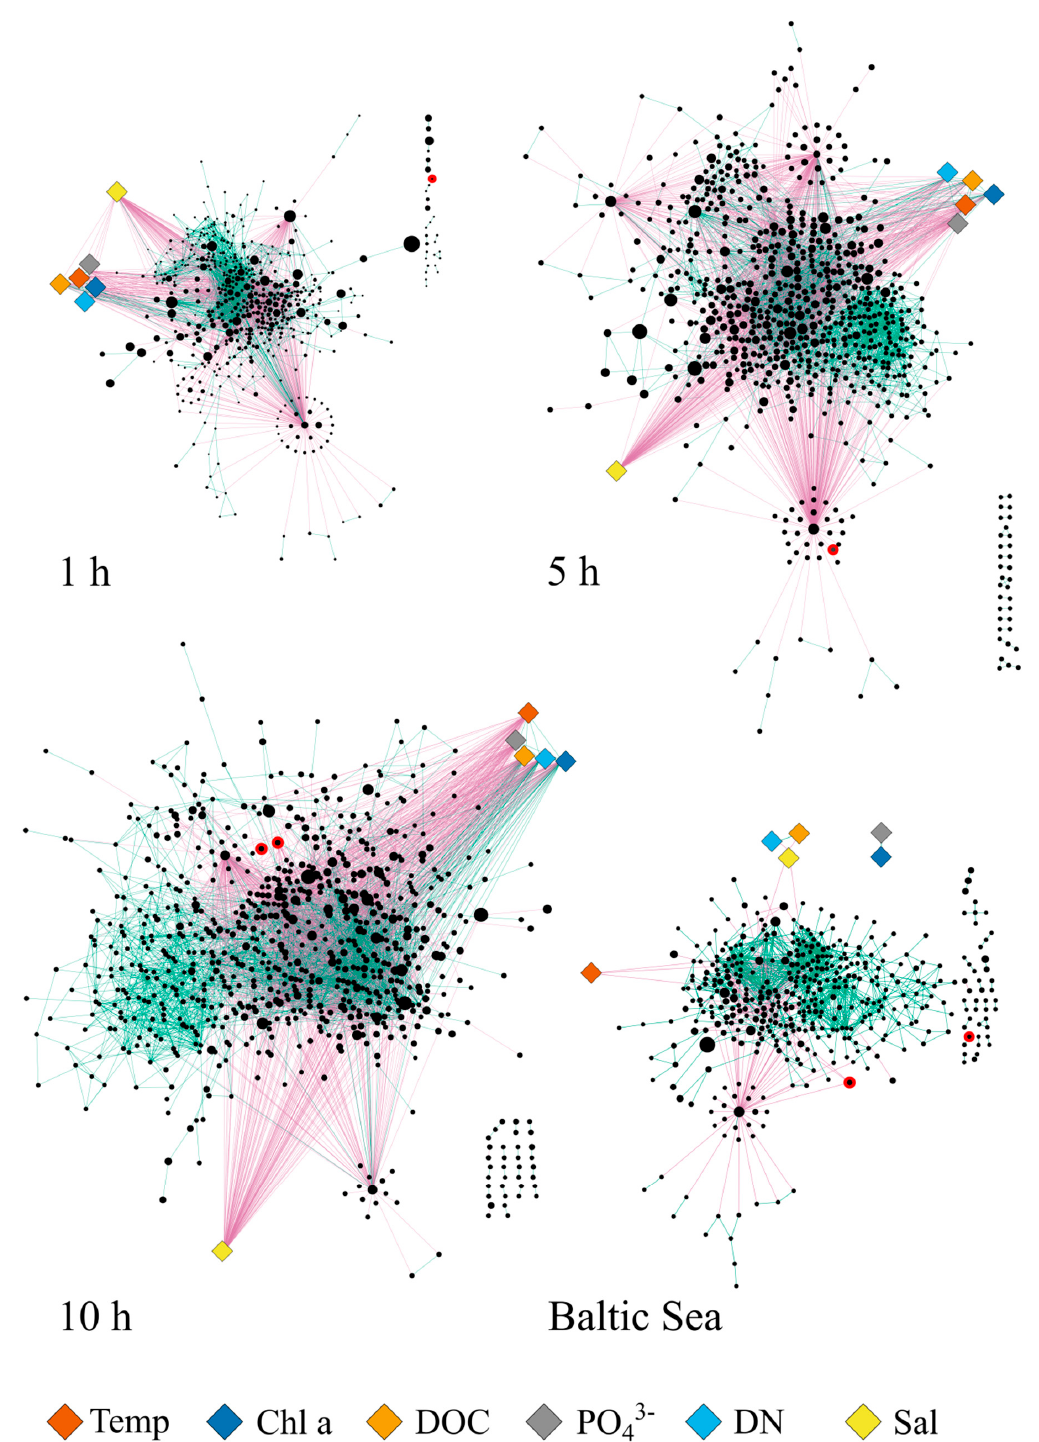
Figure 5. Co-occurrence networks of bacterial OTUs (circles), with relative abundance > 0.01% in at least three samples on plastics. Circle size represents mean abundance across all samples. Co-presence between OTUs is depicted with green edges, mutual exclusions with magenta edges. Co-occurrence networks for the exposure experiment include all stations but separated for the three different timepoints (1, 5, and 10 h), including environmental parameters (diamond shape: Temp = temperature, Chl a = chlorophyll a, DOC = dissolved organic carbon, PO 4 3 − = phosphate, DN = dissolved nitrogen, Sal = salinity). A co-occurrence network for field-collected microplastics was constructed for all stations within the Gulf of Finland. Vibrio OTUs are highlighted with a red